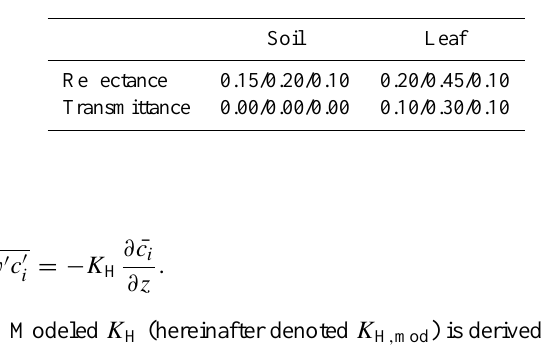
Table 1. Leaf and soil reflectance and transmittance by waveband (visible/near infrared/thermal) used in CACHE. Absorptivities are 1 − ( reflectance + transmittance ) . Values are derived from Asner